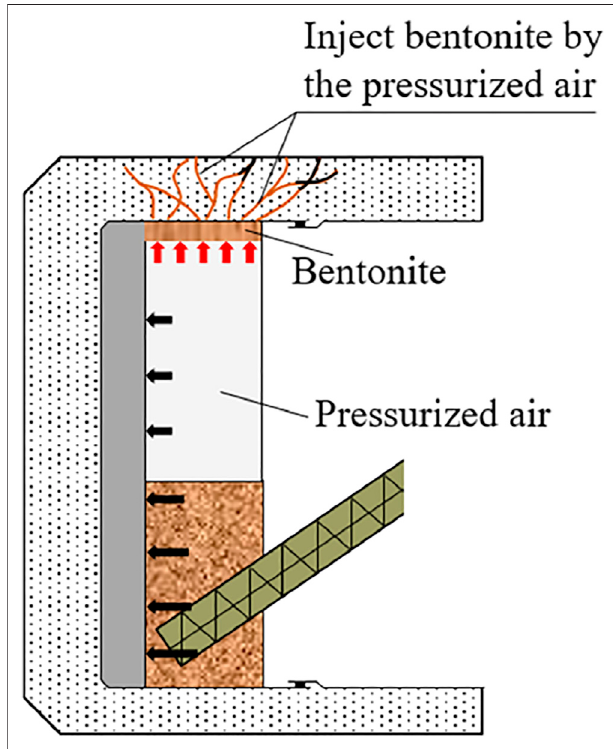
FIGURE 14 | Schematic diagram of the air-pressure tunneling mode of the shield machine.